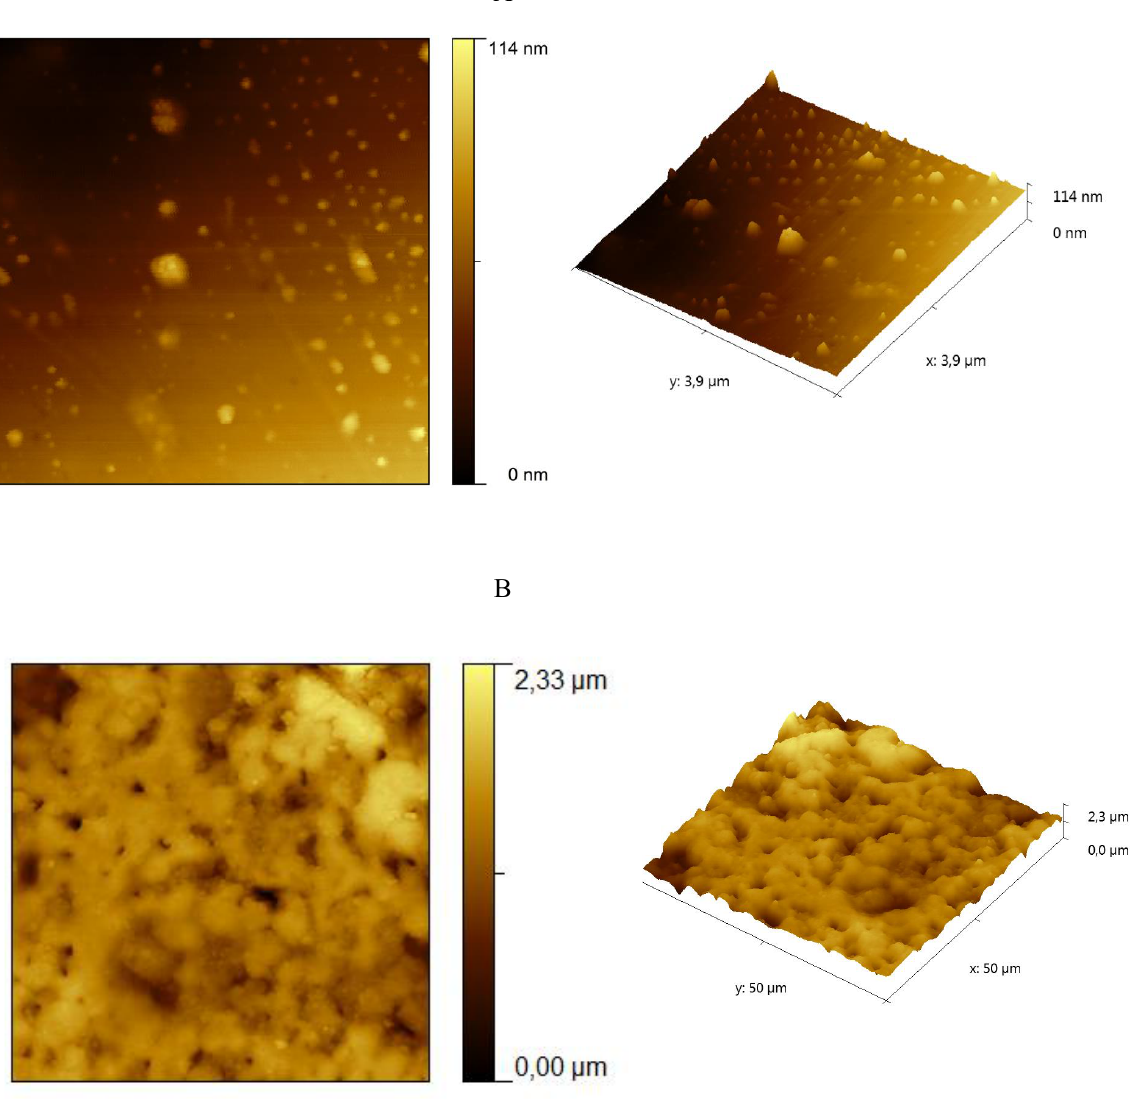
Figure 8: (A) AFM topographic image of PUDCEA coating, (B) AFM topographic image of PUDCEA-3 coating surface after exposed in salt spray.